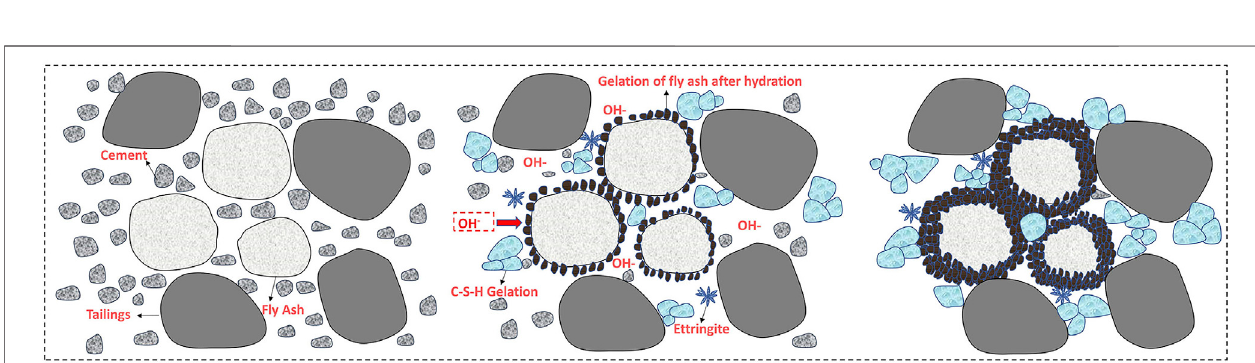
FIGURE 13 | The strength variation process of back fi